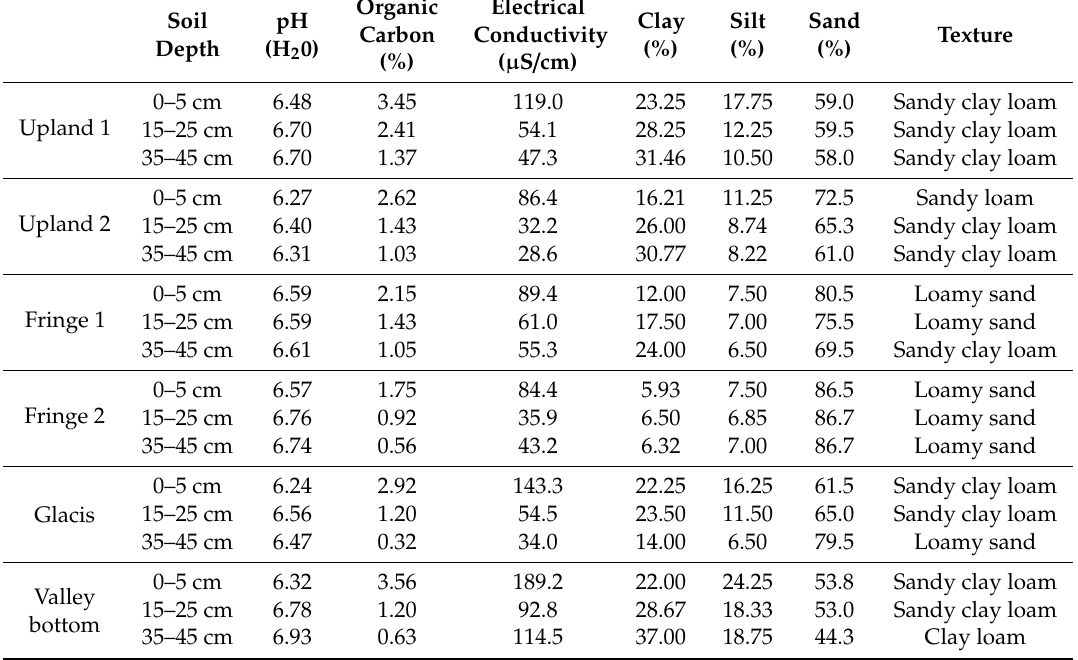
Table 1. Mean values ( n = 4) of the soil characteristics at di ff erent depths at the experimental sites. Detailed values showing their spatial variability are given in Figure S1 in the Supplementary